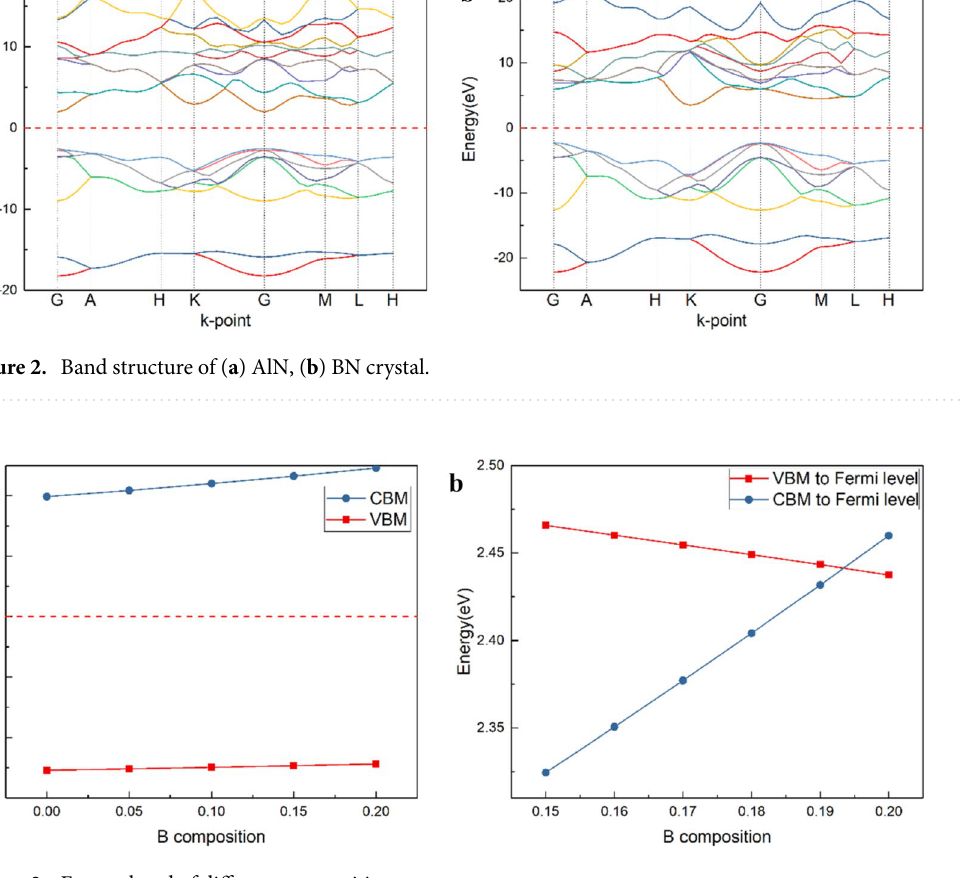
Figure 3. Energy band of different